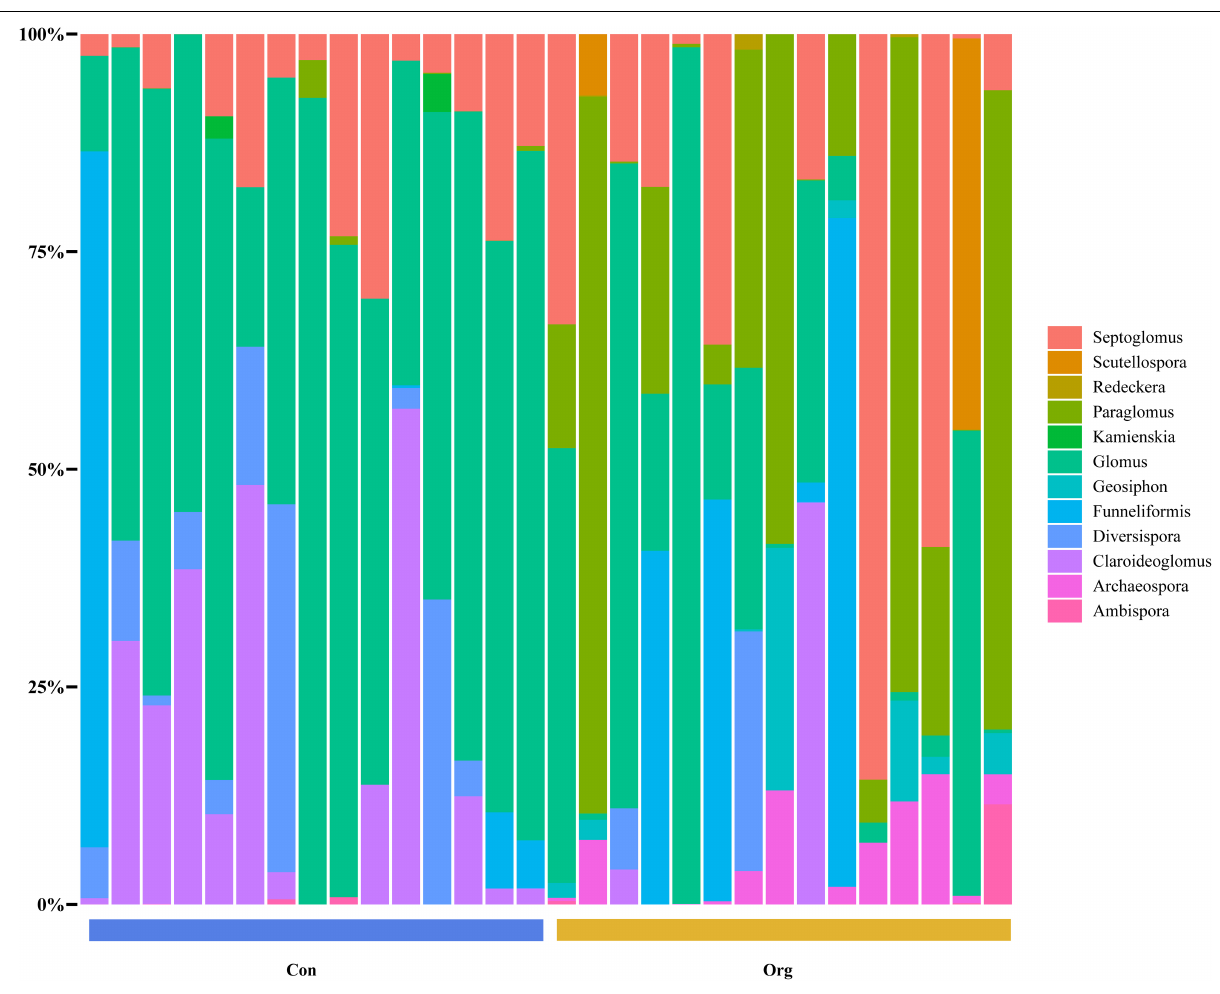
FIGURE 4 | The genus composition of soil AM fungal communities on conventional (Con) and organic (Org) maize farms.